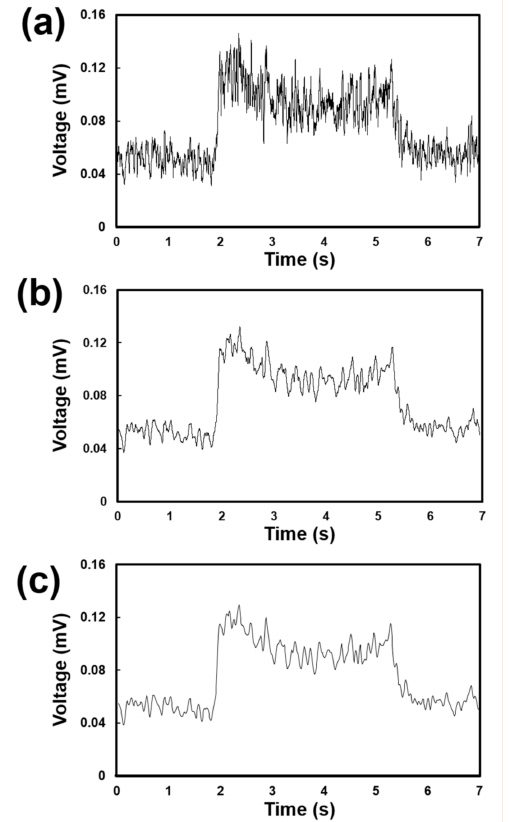
Figure 6. Signal processing procedures for sEMG data: ( a ) raw sEMG; ( b ) RMS for the raw data; and ( c ) down-sampling and moving